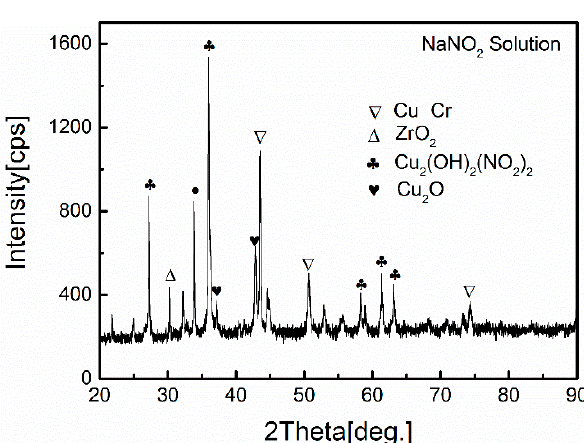
Figure 6. Corrosion mechanism diagram in NaNO 2 solution: ( a ) CG Cu-Cr-Zr alloy and ( b ) UFG Cu-